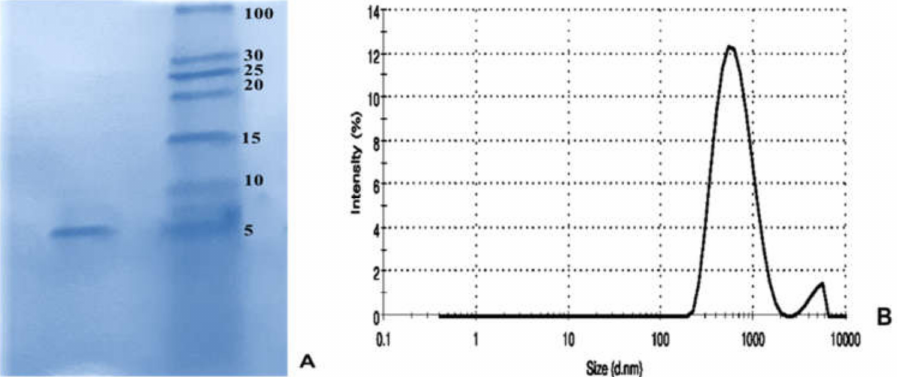
Figure 7. Refolding confirmation. ( A ) SDS-PAGE for the refolded leptucin, ( B ) Homogeneity evaluation of the refolded peptide using dynamic light